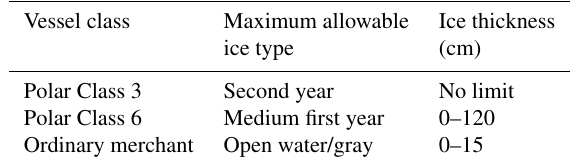
Table 1. Vessel classes versus operating ice